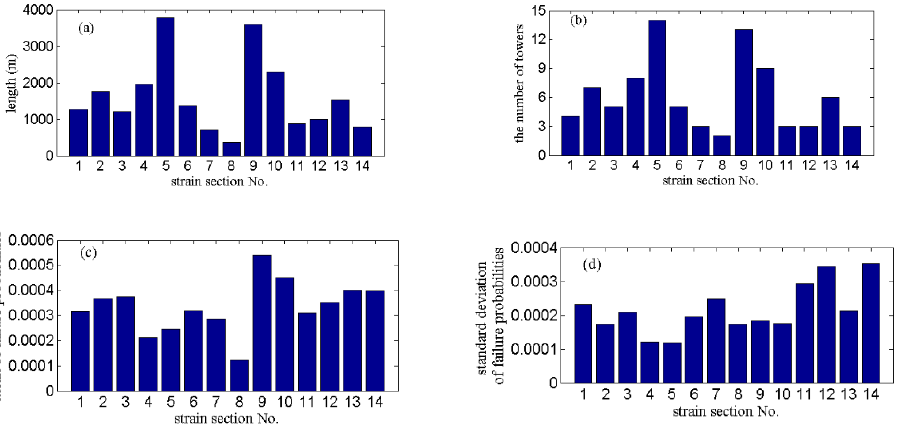
Figure 15. Strain sections and the annual failure probability of towers in each strain section. ( a ) the length of each strain section; ( b ) the number of towers in each strain section; ( c ) the mean of failure probabilities of each strain section; ( d ) the standard deviation of failure probabilities of each strain section.